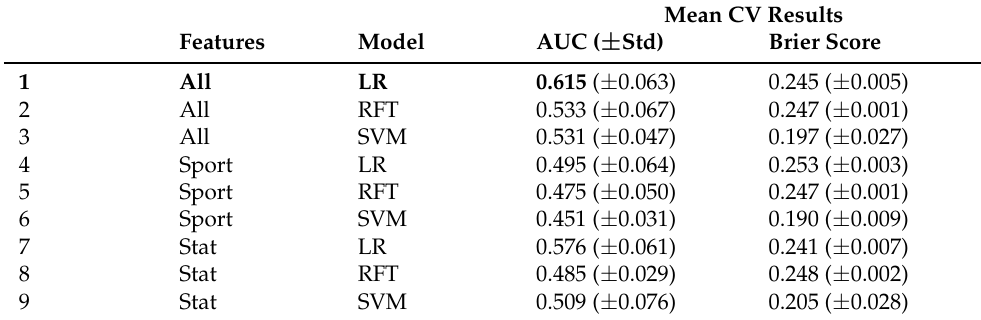
Table 6. Results for the models trained using only the data from males for different sets of features and algorithms. Either all features (All), only the sports-specific features (Sport), or only the statistical features (Stat) are used. The reported values are a mean across the scores obtained for each of the five CV